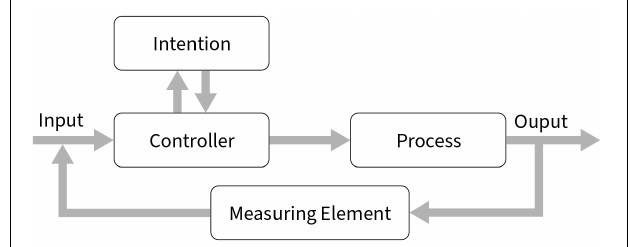
FIGURE 1 | Procedural control in a closed-loop system works similarly to any feedback loop. The input (e.g., a text) would be checked for fitting content by the controller (i.e., a steering value determined by, e.g., an intention to search for errors in a list of references) to be processed (e.g., read and